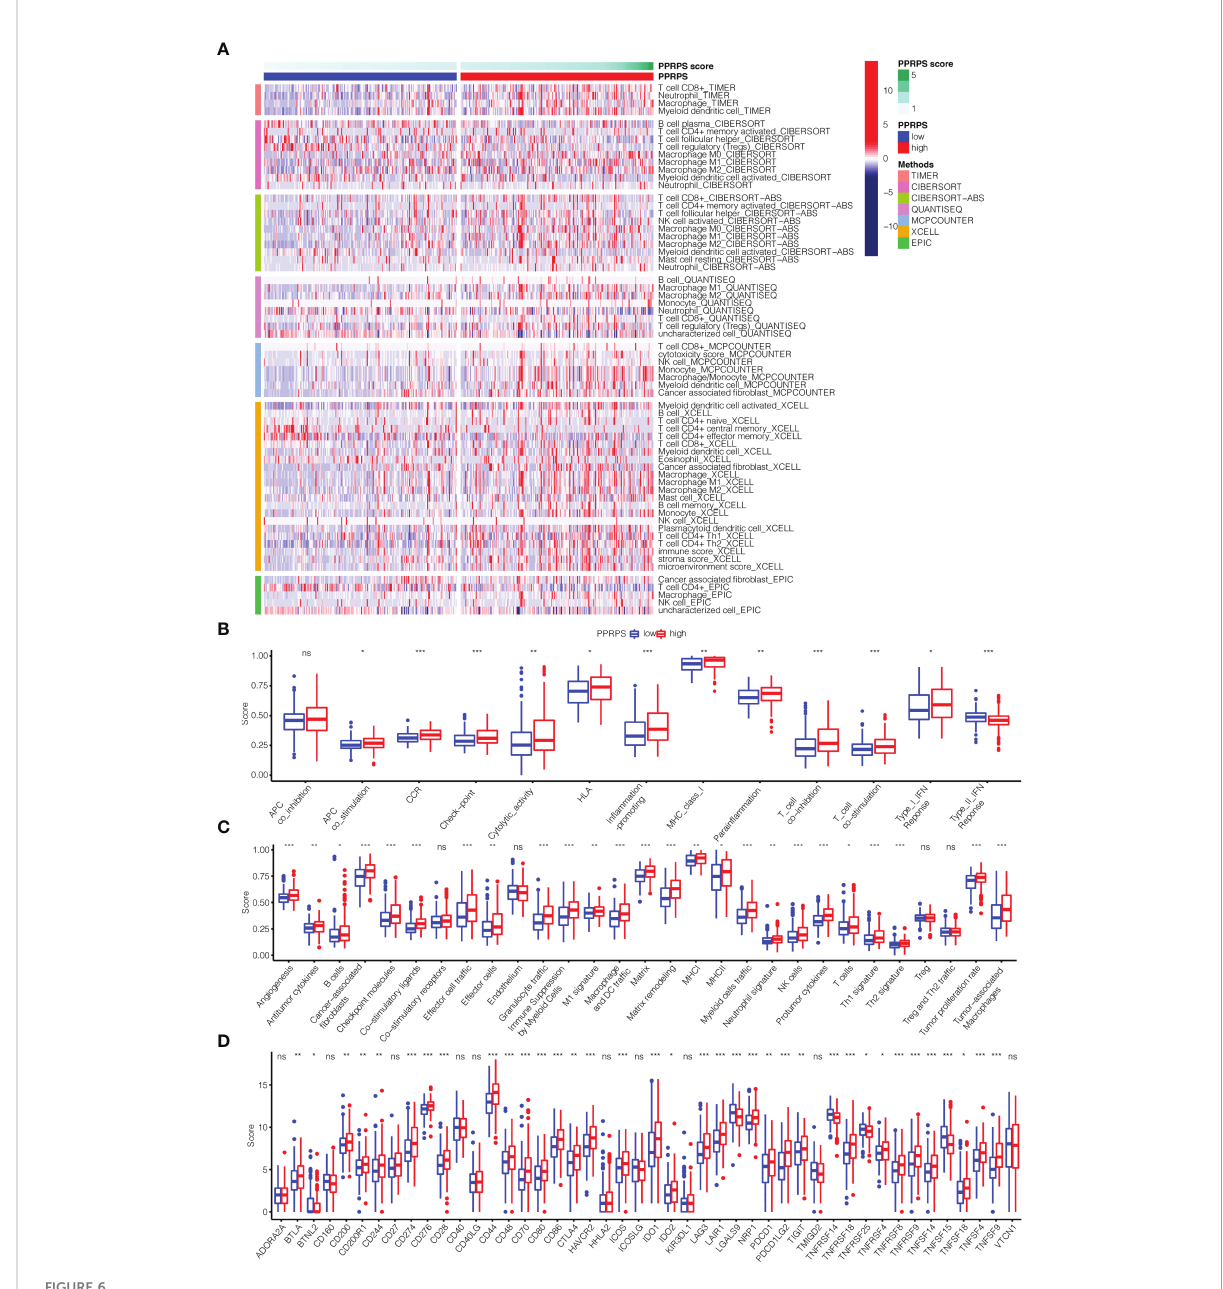
FIGURE 6 Immune microenvironment, immune-related pathways, tumor microenvironment (TME) and checkpoint genes in the low- and high-PPRPS groups. (A) Heatmap of the immune microenvironment revealing the immune cells and stromal score between the two PPRPS groups. (B) Scores of 13 immune-related pathways between the two PPRPS groups. (C) Twenty-nine functional gene expression signatures (Fges) describing the TME in the two PPRPS groups. (D) Expression of immune checkpoint genes in the high- and low-PPRPS groups. *p < 0.05, **p < 0.01, ***p < 0.001, ns, not signi fi